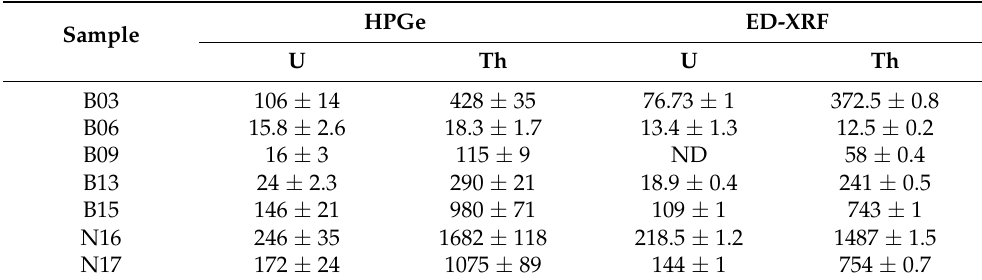
Table 7. Total activity ± SD (in Bq) for U and Th. A comparison between the results of Table 5 (HPGe) and Table 1